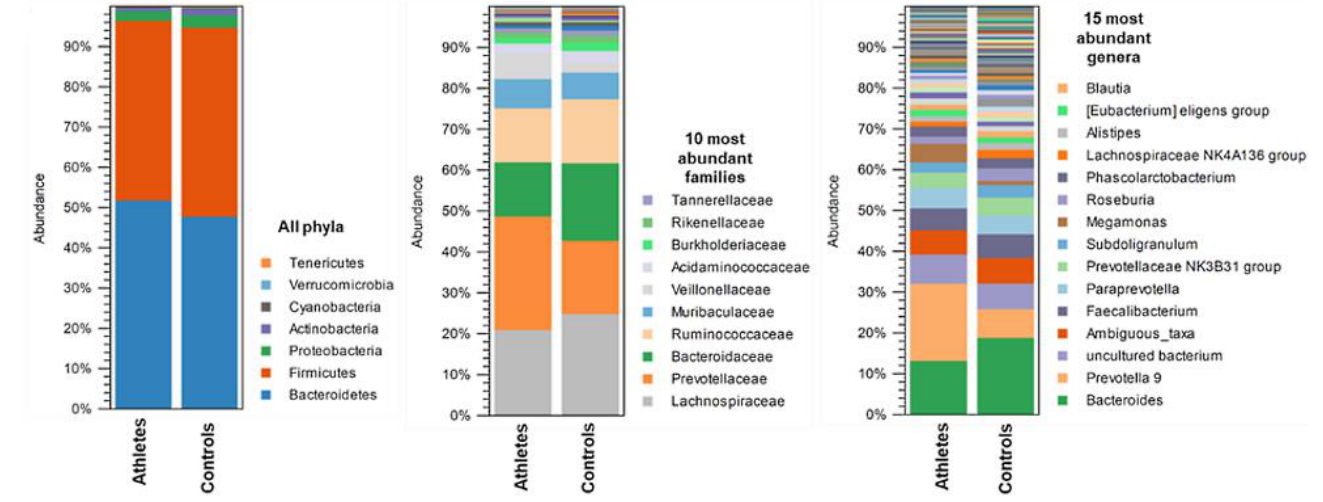
Figure 2. The average gut microbiota composition in the athletes ( n = 27) and controls ( n = 27) at phylum, family, and genus level.